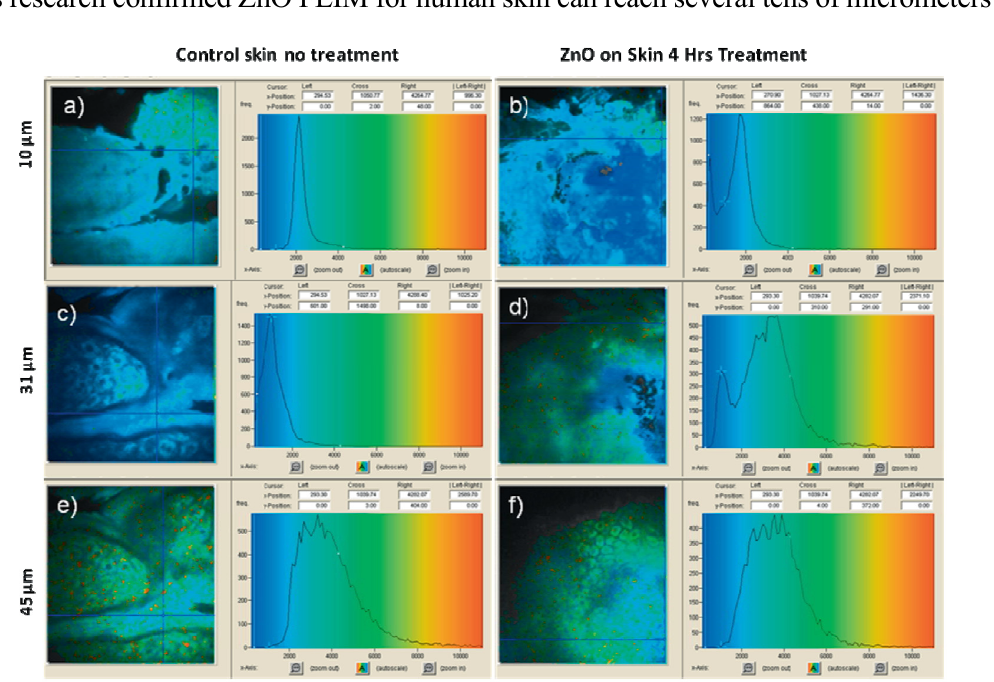
Figure 5. In vivo control and treated skin after exposure of ZnO for 4 h intensity versus life times for ZnO, stratum corneum, and viable epidermis. 740 nm excitation, channel 1 (350~415 nm), field of view 175:175 μ m. ( a ) Stratum corneum control, ( b )